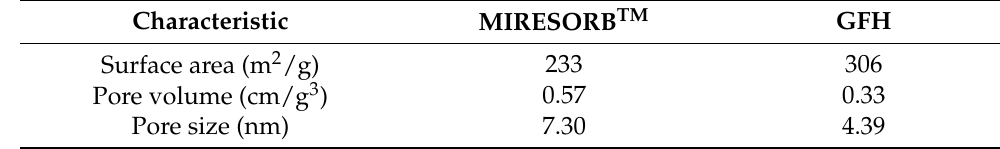
Figure 2. ( a ) N 2 adsorption/desorption isotherm; ( b ) The Barrett, Joyner, Halenda (BJH) pore volume distributions, for GFH and MIRESORB TM materials. Table 2. Surface areas, pore volumes, and pore sizes of the adsorbent materials.